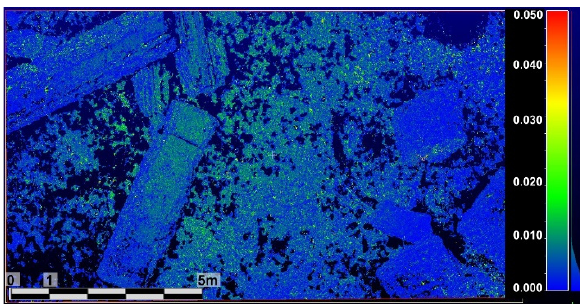
Figure 5. Cloud G2 to reference cloud deviation